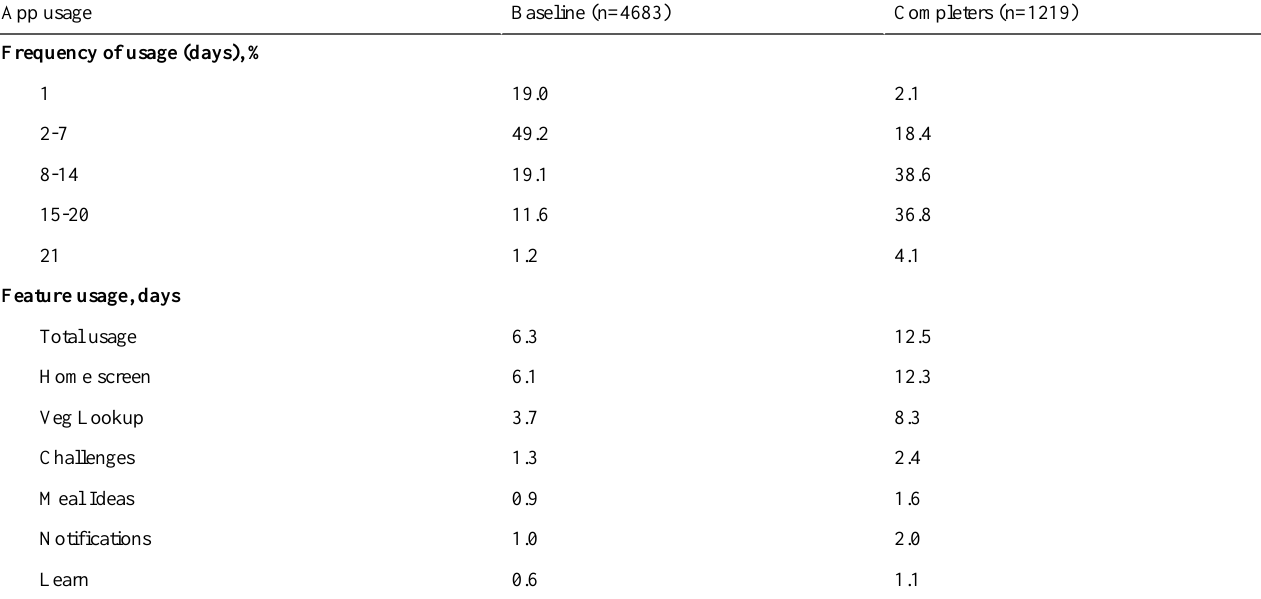
Table 3. Percentage of the sample actively using the VegEze app, for the baseline sample and for those that completed the